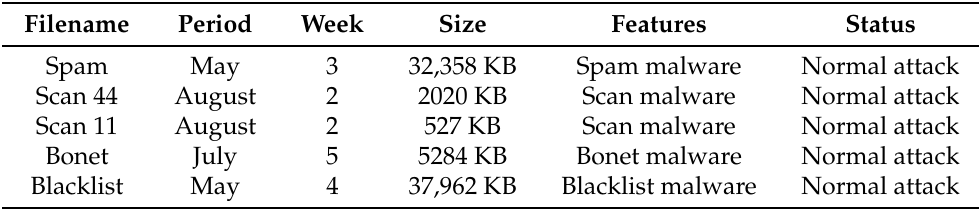
Table 4. The UGR’16